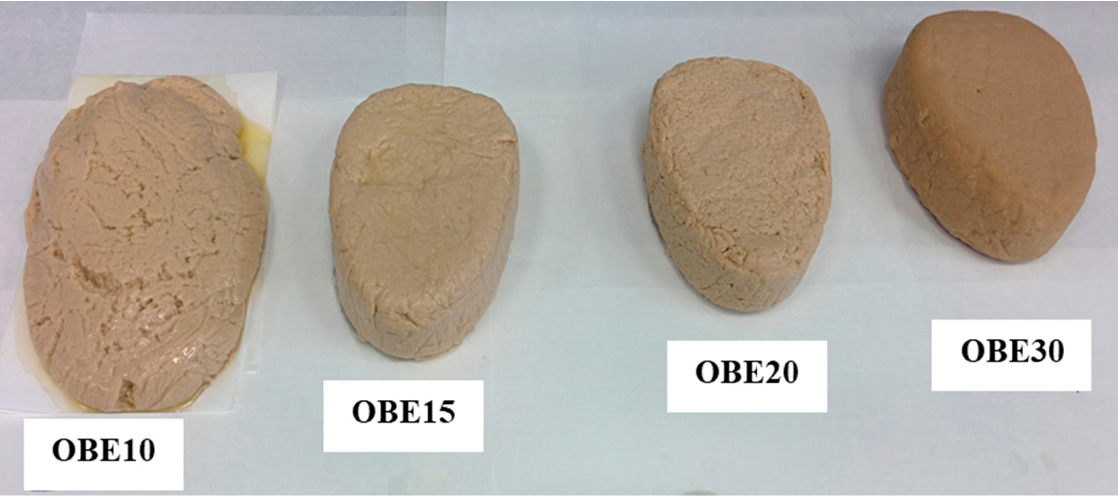
Figure 1. Typical appearance of different oat bran O/W emulsions formulated with 10% (OBE10), 15% (OBE15), 20% (OEB20), and 30% (OBE30) oat bran. See Table 1 for a sample